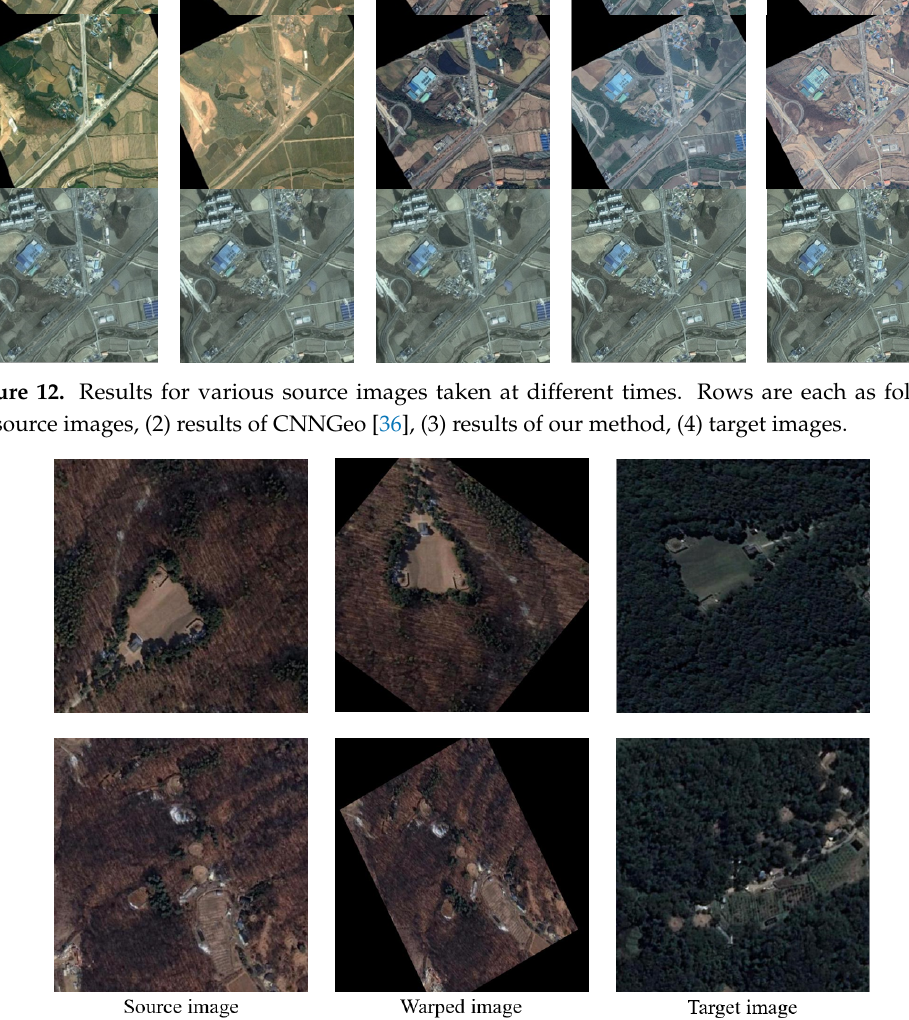
Figure 13. Failure cases, which primarily consist of wooded areas. Although there are objects that can be focused, it fails